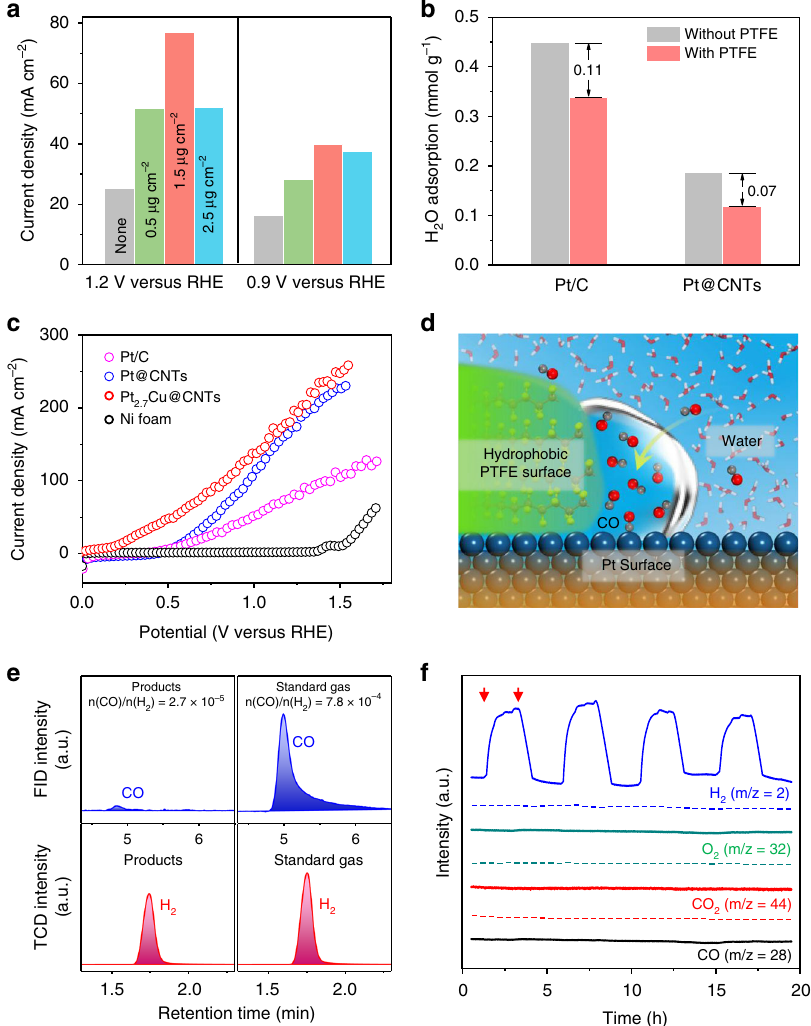
Fig. 2 Optimization of anode structure and performance of the EWGS process. a Current densities of CO oxidation on Pt/C catalyst decorated with different content of PTFE at 0.9 and 1.2 V versus RHE, respectively. b Adsorption of H 2 O at 25 °C on Pt/C and Pt@CNTs with and without PTFE treatment detected by intelligent gravimetric analyzer. c Linear sweep voltammetry polarization curves of the CO oxidation catalyzed by Pt/C, Pt@CNTs, Pt 2.7 Cu@CNTs, and Ni foam, all decorated with 1.5 μ g cm − 2 PTFE. d Schematic illustration of solid/liquid/gas interfaces on the PTFE-decorated Pt surface. e Gas chromatography analysis of hydrogen purity for the cathodic products at a constant potential of 1.0 V versus RHE using Pt@CNTs as the anode catalyst, calibrated with the speci fi c concentration of CO/H 2 standard gas. f Mass spectrometry detection of the anodic (dotted line) and cathodic (solid line) products using Pt@CNTs as the anode catalyst at a constant current density of 20.0 mA cm − 2 . The red arrows denote starting and ending of CO